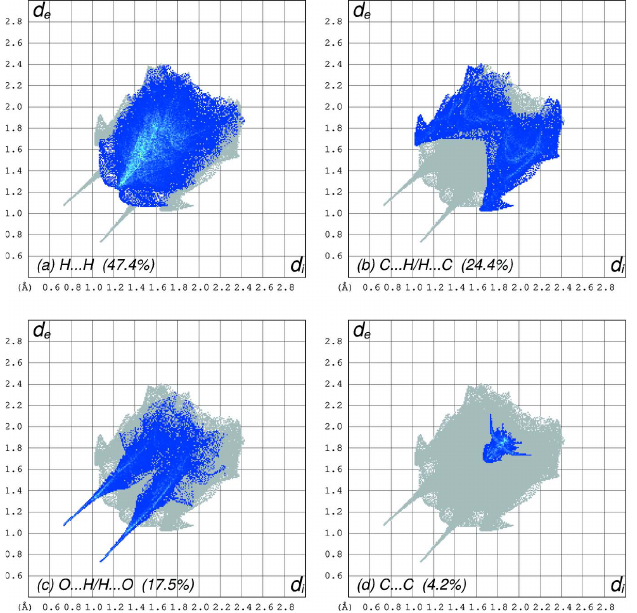
Figure 8 Fingerprint plots obtained from a Hirshfeld surface analysis for I using CrystalExplorer , separated into ( a ) H (cid:2)(cid:2)(cid:2) H (47.4% coverage), ( b ) C (cid:2)(cid:2)(cid:2) H/ H (cid:2)(cid:2)(cid:2) C (24.4%), ( c ) O (cid:2)(cid:2)(cid:2) H/H (cid:2)(cid:2)(cid:2) O (17.5%), ( d ) C (cid:2)(cid:2)(cid:2) C (4.2%). All other contacts are